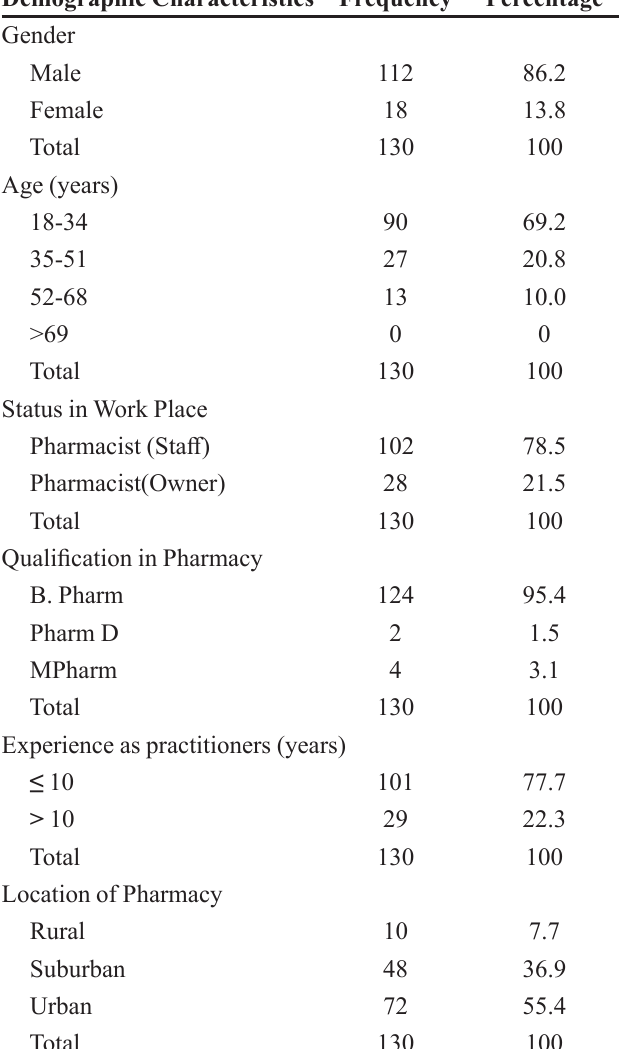
TABLE I - Characteristics of community pharmacists (N=130) Demographic Characteristics